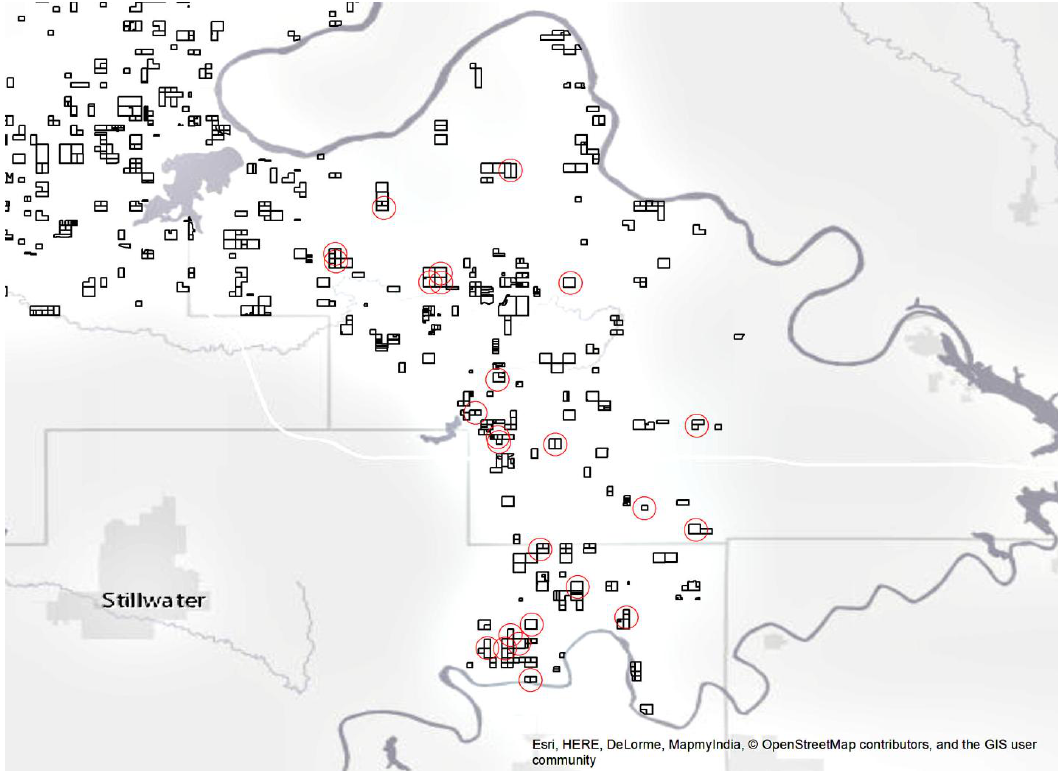
Figure 2. BIA-managed properties in this area of the Southern Plains region are outlined in black. The 25 properties randomly selected for field measurements in this study are circled in